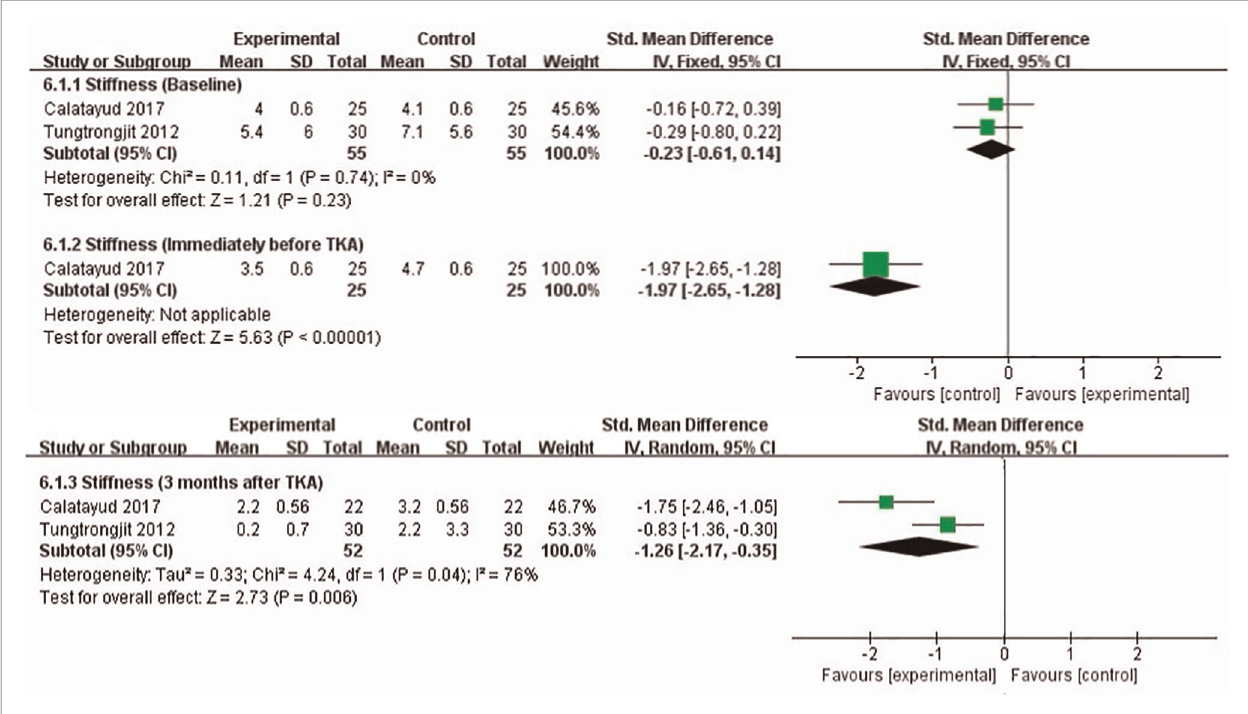
FIGURE 8 | Meta-analysis on